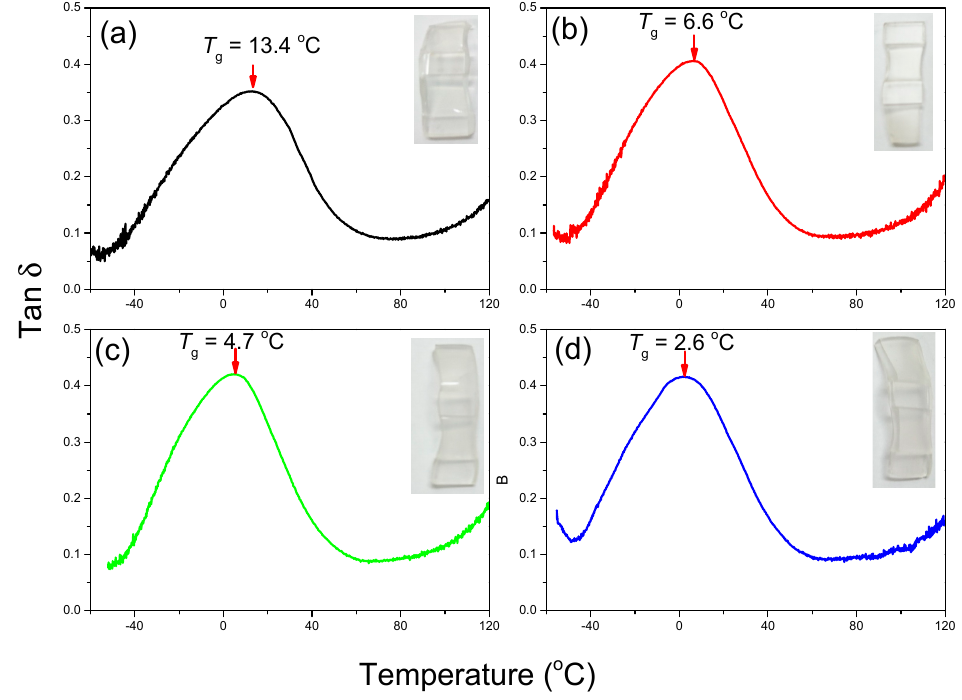
Figure 6. DMA analyses of various PVC/DINCH/MA-POSS blends: ( a ) 100/60/0, ( b ) 100/60/5, ( c ) 100/60/10, and ( d ) 100/60/15. The inset displays the transparent films obtained after DMA analysis of each composition.